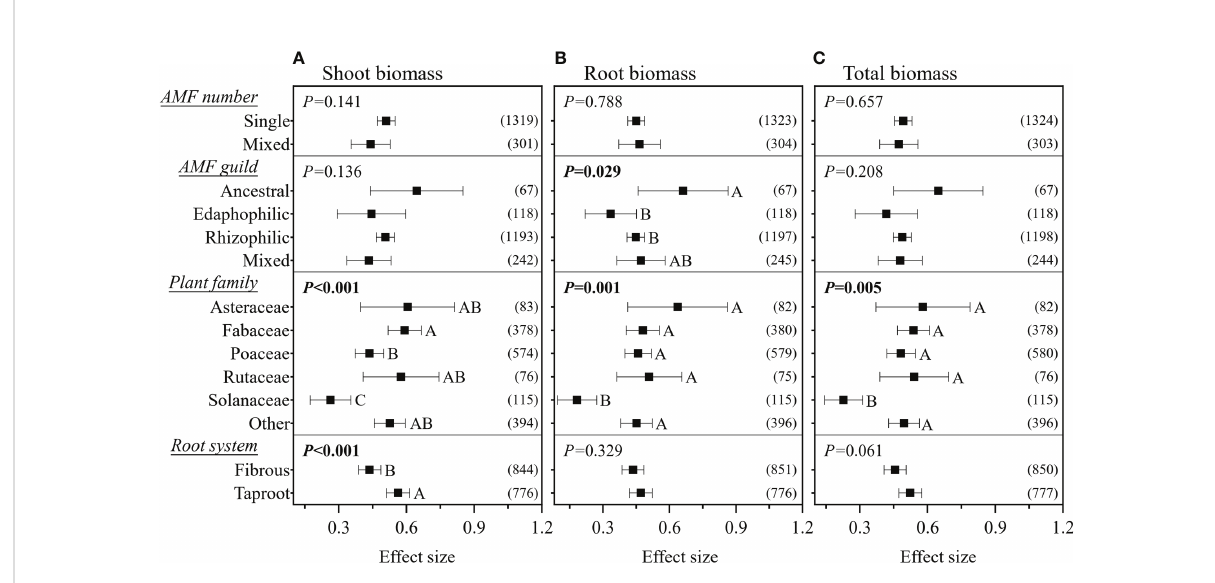
FIGURE 3 Effect of arbuscular mycorrhizal fungi (AMF) number and guild, plant family, and root system on the effect size of AMF on plant shoot (A) , root (B) , and total (C) biomass. Values in parentheses are the number of observations included in the analysis. The signi fi cance test for between-level differences was based on a random effects model with a residual maximum likelihood (REML) method. P -values ≤ 0.05 were considered signi fi cant. Different capital letters indicate signi fi cant differences compared with the other groups as assessed using a random effects model with a REML